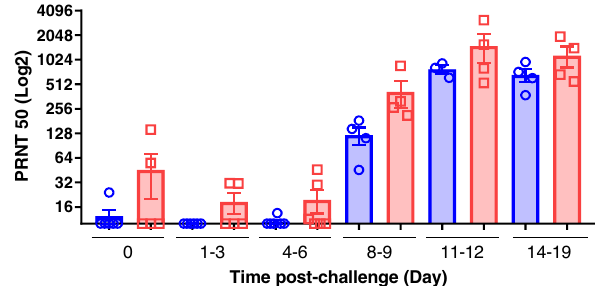
Fig. 7 Neutralising antibodies in serum measured by Plaque reduction neutralisation test (PRNT 50 ). Serum neutralisation titres as reciprocal highest dilution resulting in an infection reduction of >50% in samples (PRNT 50 ) pre-challenge and at 1 – 3, 4 – 6, 8 – 9, 11 – 12 and 14 – 19 days post- challenge in rhesus macaques (blue) and cynomolgus macaques (red). For